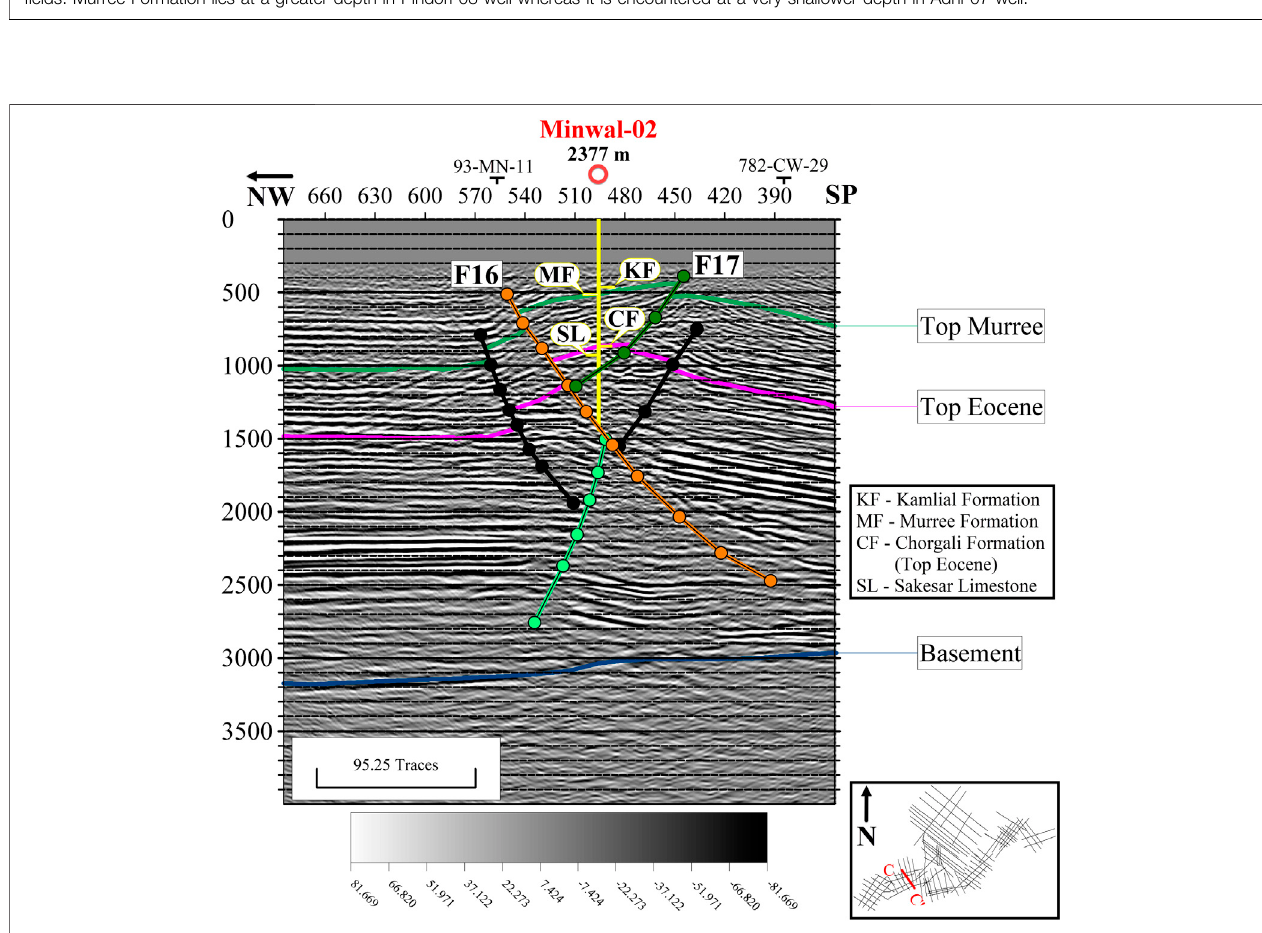
FIGURE 7 | Interpreted seismic section of line POL-93-MN-08 of Minwal fi eld in zone-3. Triangular zone is interpreted in the area at a deeper level where Murree Formation forms pop-up geometry at a very shallow depth. Frontiers in Earth Science |